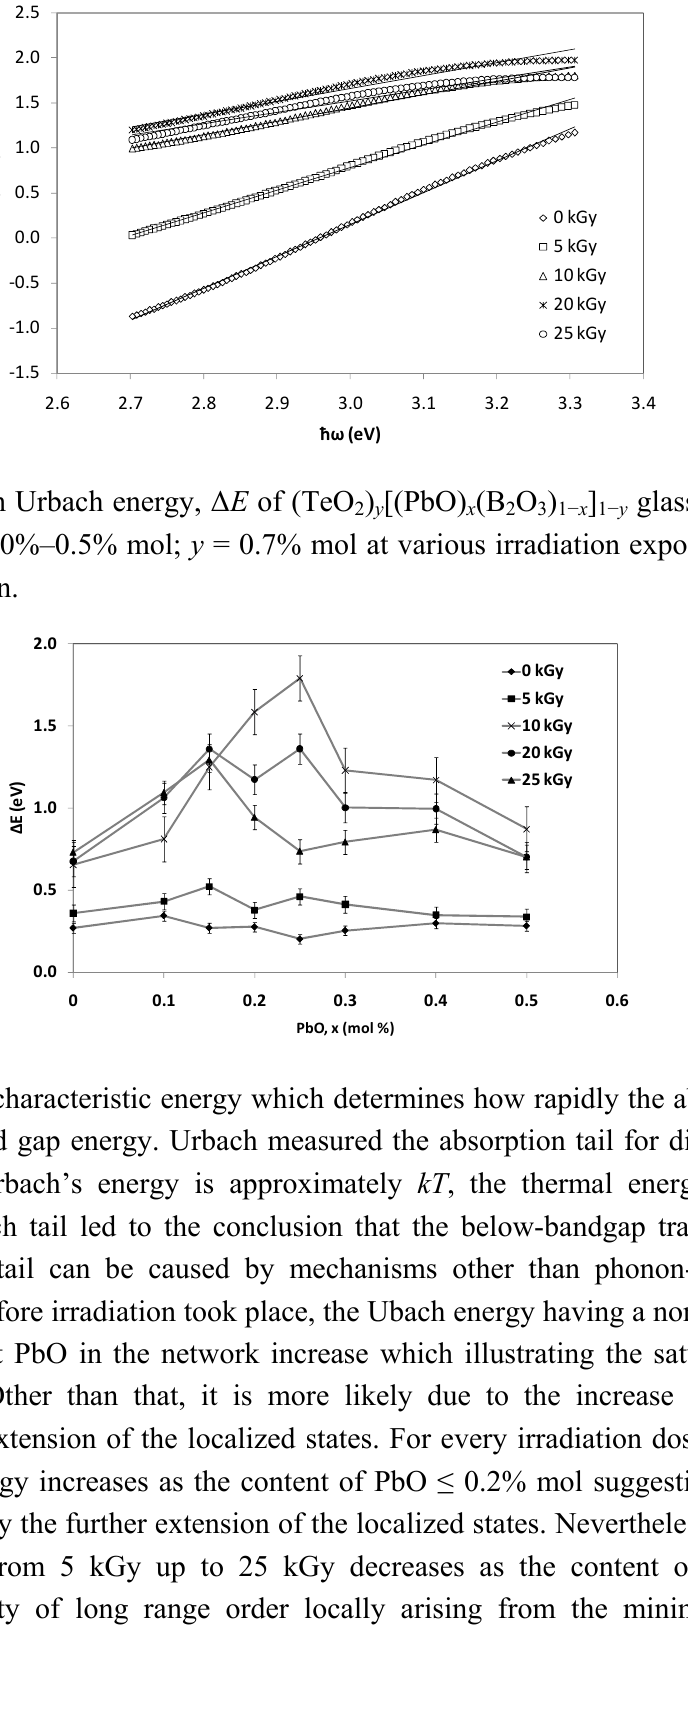
) [(PbO) (B O ) ] glasses with 2 y x 2 3 1 − x 1 − y